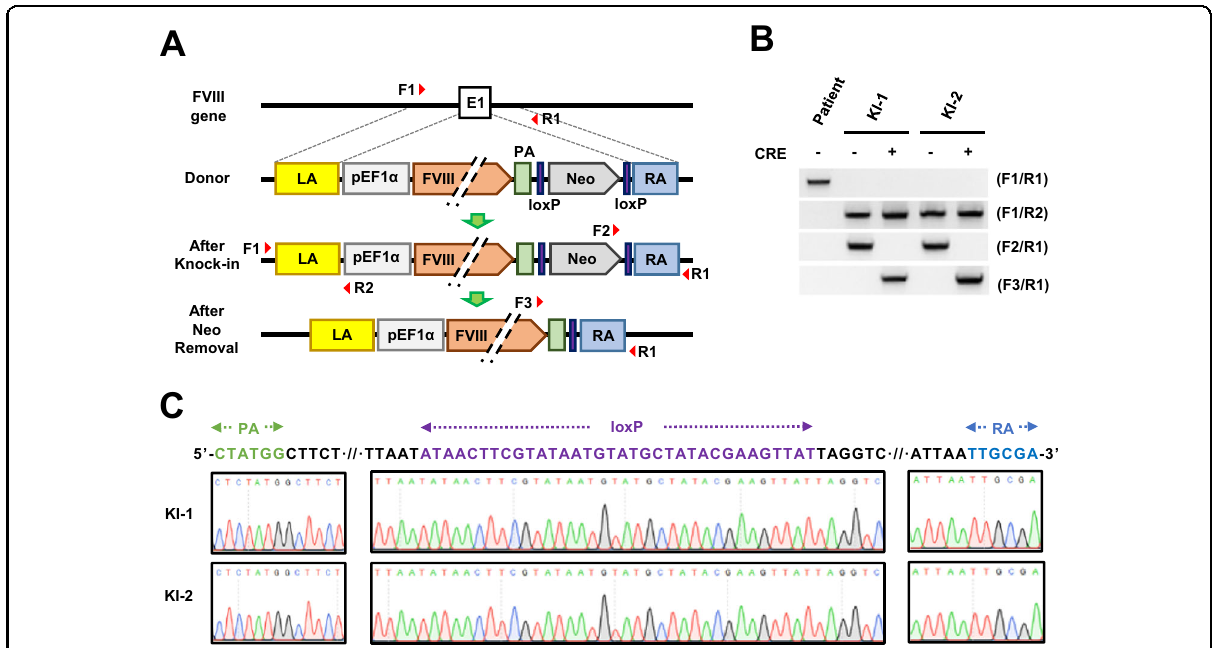
Fig. 1 Site-speci fi c integration of the FVIII gene at a hemophilia A patient ’ s FVIII locus. a A schematic representation of the targeted insertion of the FVIII gene at the human FVIII locus and the excision of the neomycin resistance cassette. Top depicts exon 1 of the human FVIII locus, and below shows donor plasmid, which consists of a 1113 bp left arm (LA), human EF1 α promoter (pEF1 α ), BDD form of FVIII (FVIII), bovine growth hormone polyadenylation signal (PA), loxP - fl anked neomycin resistance cassette (Neo), and 786 bp right arm (RA). The neomycin resistance cassette was removed by Cre expression after the knock-in of the donor plasmid. Primers used in PCR analysis are represented by red arrowheads. b Genomic PCR analysis of gene-corrected clones before ( − ) and after ( + ) Cre expression in the gene-corrected cell lines KI-1 and KI-2. The F1/R1 primer pair was used to detect exon 1 (E1) of the FVIII locus. The primer sets F1/R2 and F2/R1 were used to detect the knock-in junctions of the 5 ′ and 3 ′ ends in correctly targeted clones. The F3/R1 primer pair was used for detecting the removal of the neomycin resistance cassette. Genomic DNA from parental patient iPSCs was used for the control (patient). c Partial chromatograms from a 1626 bp PCR amplicon generated with F3/R1, showing the sequences around loxP in KI-1 and KI-2 cell lines after removal of the neomycin resistance cassette. Partial bGH poly A signal (PA), loxP , and partial right arm (RA) shown in green, purple, and blue,